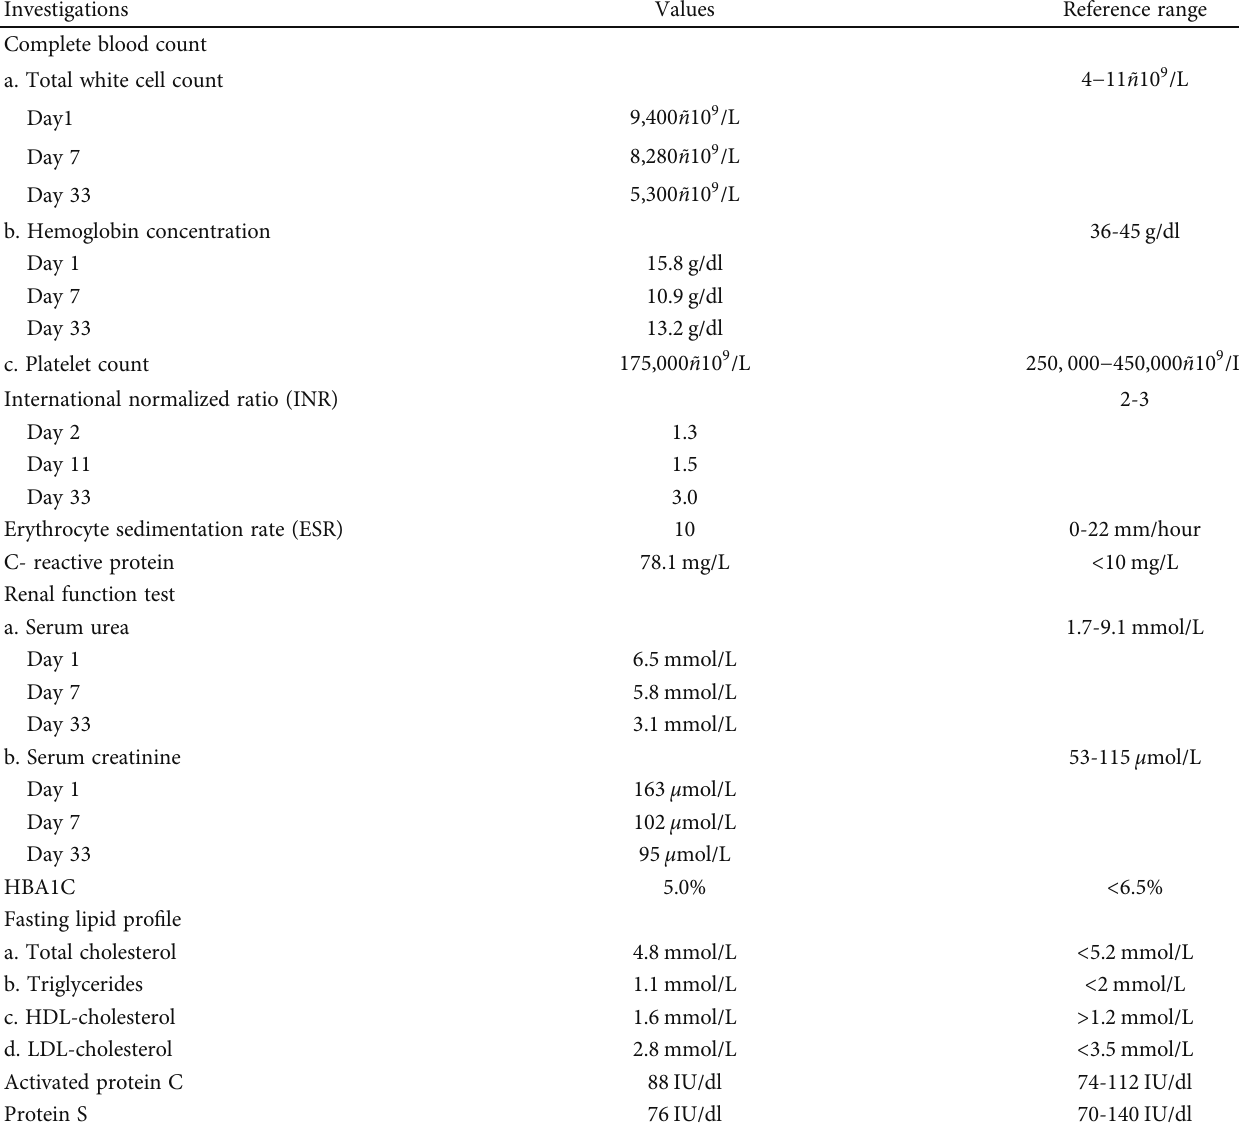
Table 1: The laboratory parameters of the index